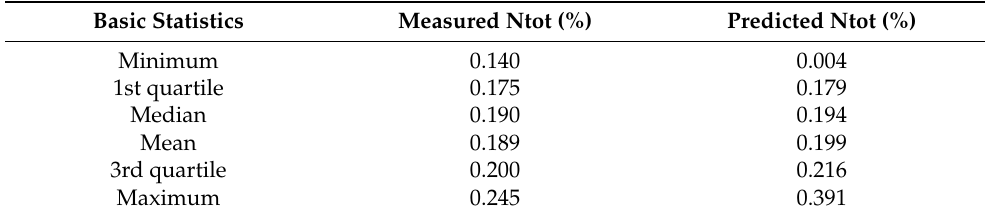
Table 6. Summary for measured and predicted